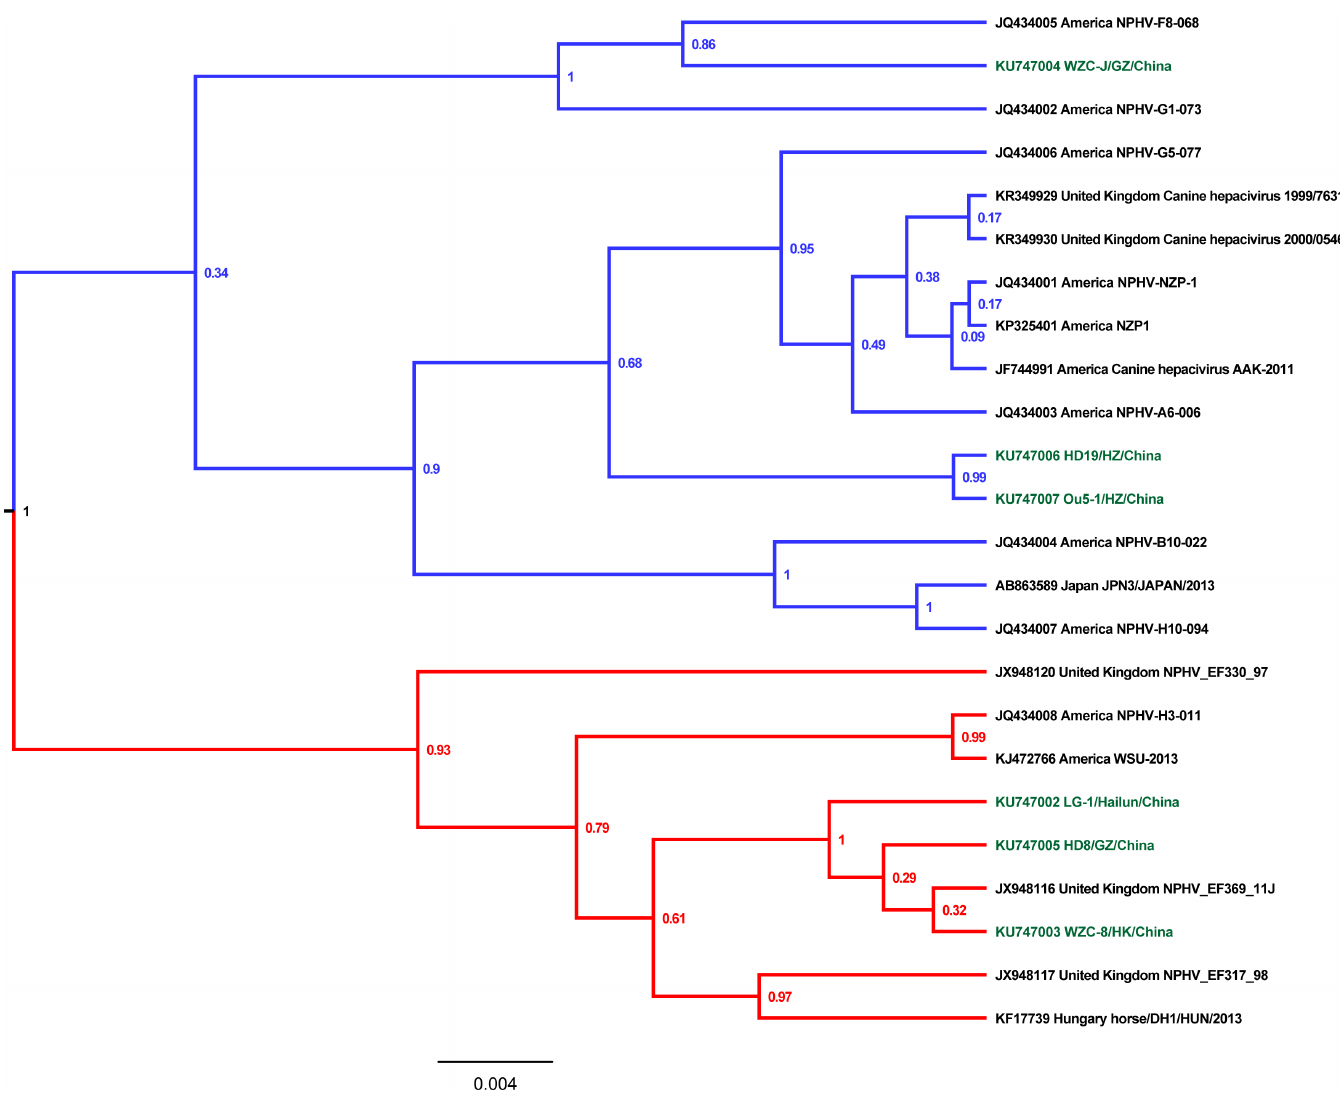
Fig 3. Phylogenetic analysis of the partial 5 ’ UTR nucleotide sequences from EqHV. The analysis method has been described in Fig